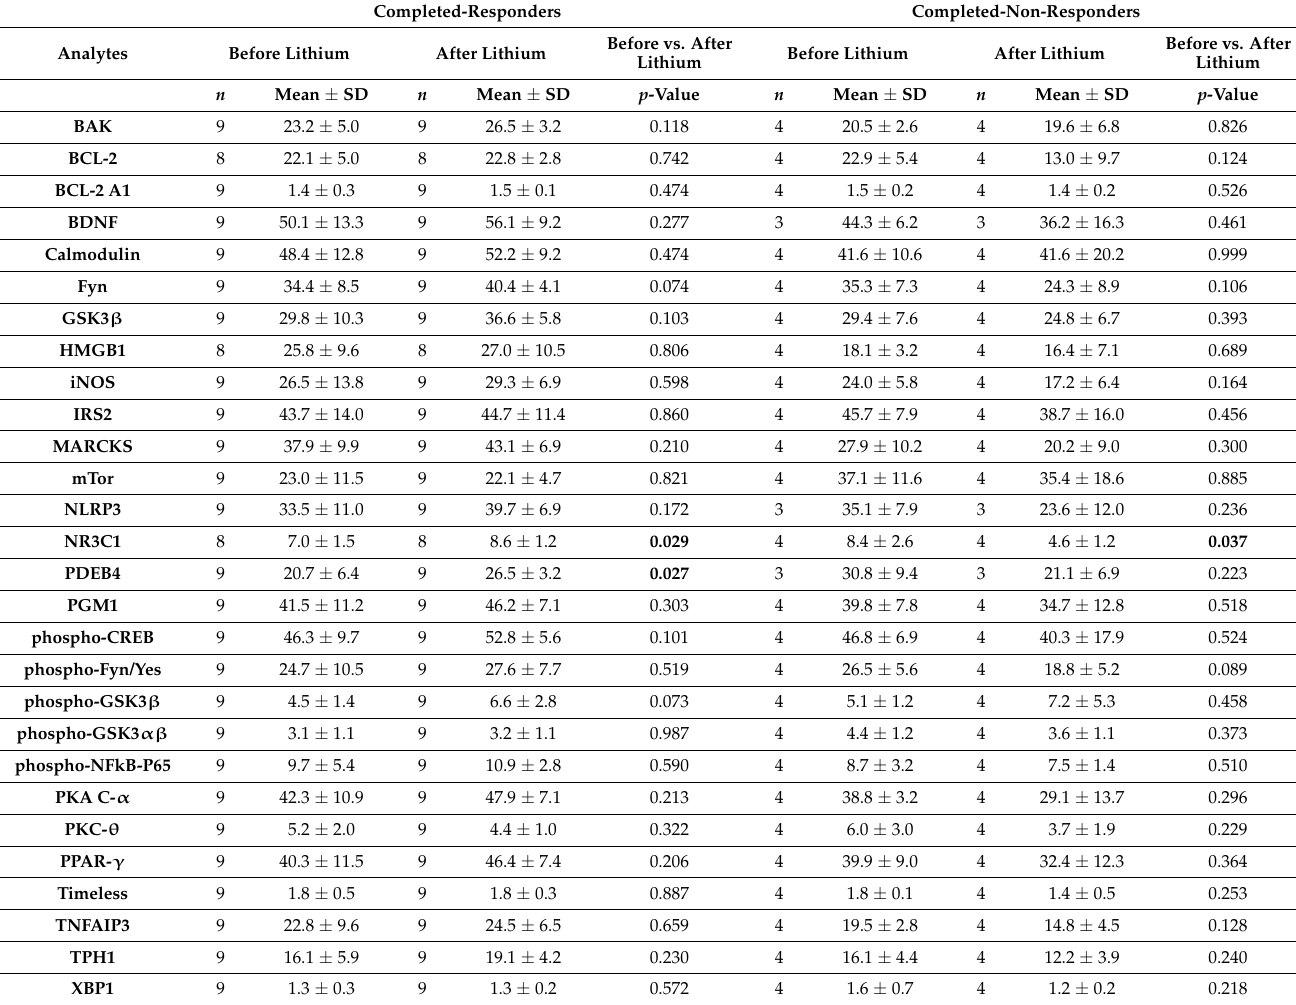
Table 2. Comparison of protein levels in monocytes of lithium completed responders and non- responders between before and after lithium